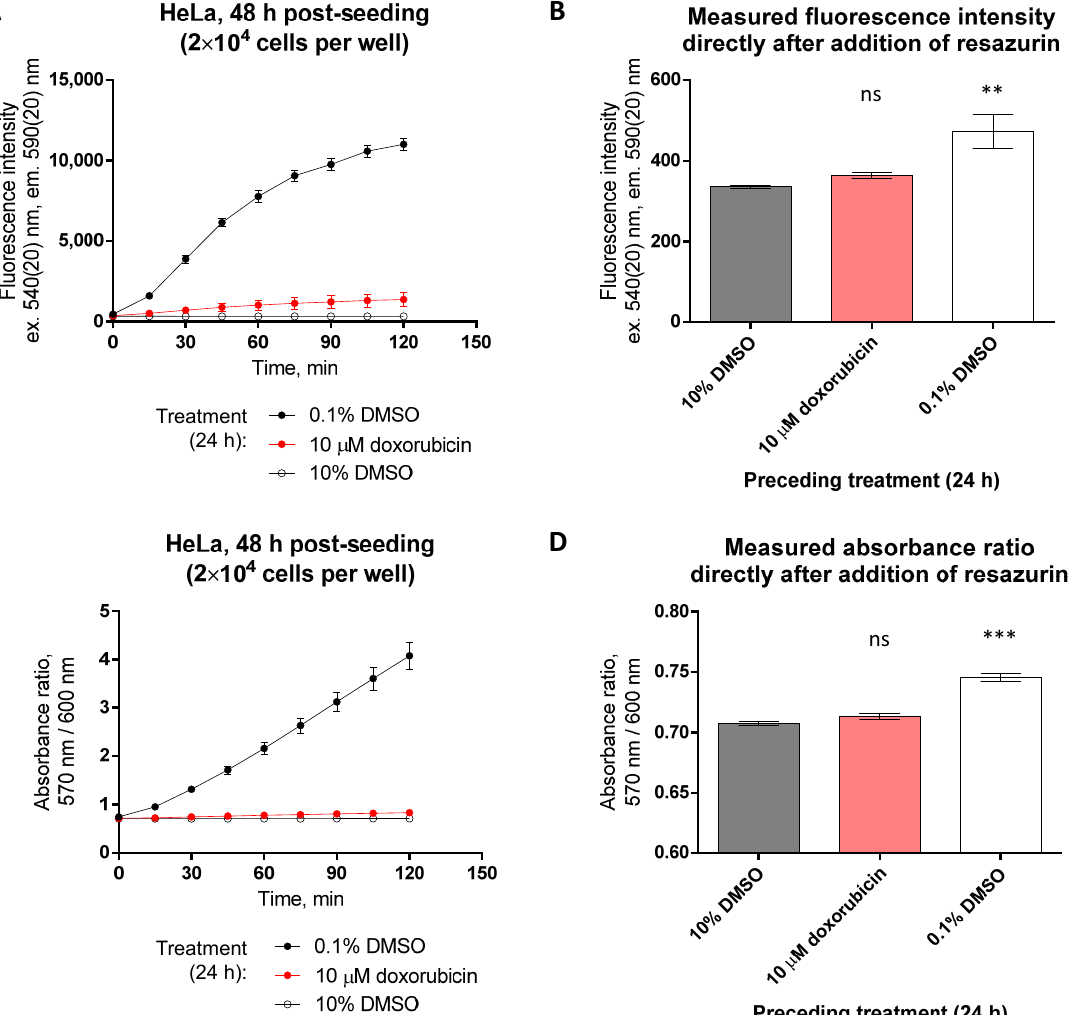
Figure 9. Pre-treatment of HeLa cells with fluorescent compound doxorubicin does not interfere with detection of resazurin fluorescence or absorbance ratio in solution. Cells were treated with compounds for 24 h prior to measurement of viability (at 48 h post-seeding). ( A , C ) Monitoring of change in fluorescence intensity (excitation at 540 nm) or absorbance ratio (570 nm/600 nm) during incubation of differently treated cells (conditions listed under the graphs) with 40 µ M resazurin. ( B , D ) Values of fluorescence intensity or absorbance ratio directly following the addition of resazurin solution onto the cells (corresponding to the 0 min datapoint in graphs A and C, respectively). Please note the differences of the y-scale values in ( A ) vs. ( B) and in ( C ) vs. ( D ). In each graph, an average of duplicates ± SEM from two independent experiments is shown. The statistical significance of difference between the zero-viability control (10% DMSO) and other treatments was assessed using 1-way ANOVA with Dunnett’s test for multiple comparisons; *** indicates p ≤ 0.001, ** indicates p ≤ 0.01, and ns indicates not significant. The significance of 0.1% DMSO vs. 10% DMSO treatment indicates the start of resazurin-to-resorufin conversion in viable cells within seconds following the addition of resazurin.